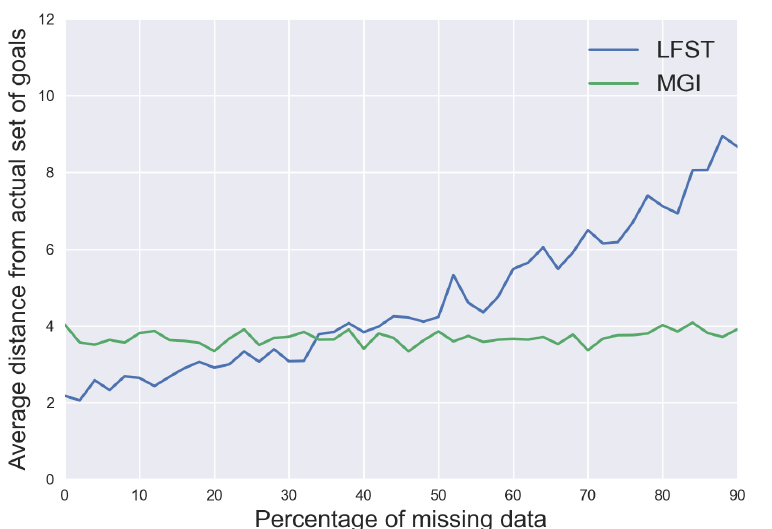
Figure 5. Comparison of the average distance from the actual goals in GridWorld.